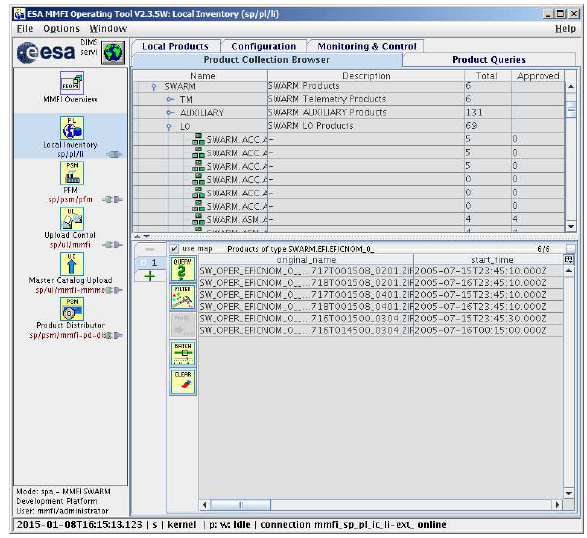
Figure 5: Operations User Interface